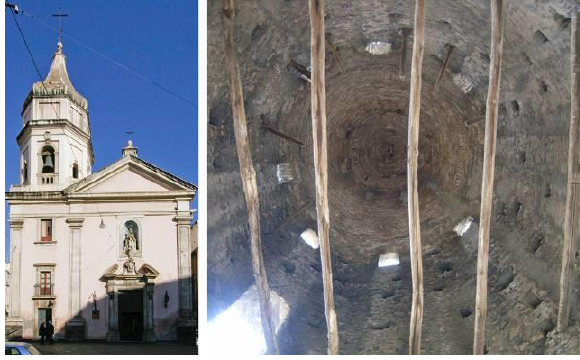
Figure 3. The bell tower of Santa Maria di Monserrato in Catania. On the right, original beams of the floor under the cusp.